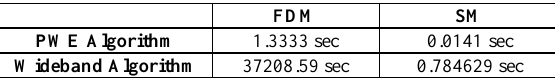
Table 2. Computation Times of FDM and